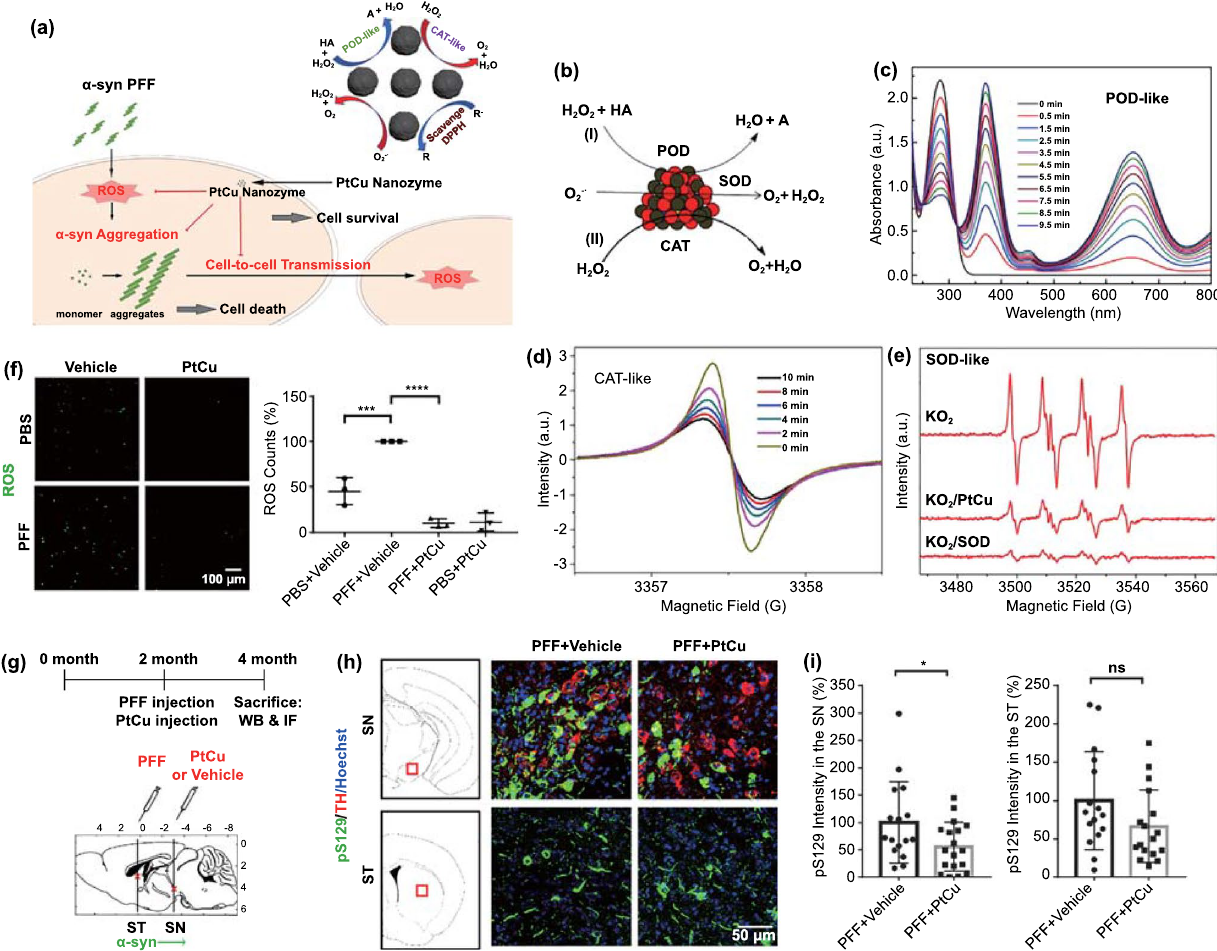
Fig. 10 Example of nano-bio effects resulting in the clearance of excessive ROS. a Schematic showing how the PtCu nanozyme scavenges ROS and prevents α-synuclein-induced pathology, neurotoxicity, and cell-to-cell transmission in vitro and in vivo. b Schematic showing how PtCu Nas mimic three redox enzymes (POD: peroxidase, SOD: superoxide dismutase, CAT: catalase). c UV–Vis spectra of TMB in the presence of H 2 O 2 catalyzed by POD-like PtCu Nas. d CAT-like activity of PtCu NPs in reducing H 2 O 2 , demonstrated by electron spin resonance (ESR) oxi- metry; the evolution of the ESR spectra of PDT over time in the presence of 2 Mm H 2 O 2 before and after the addition of PtCu NPs in a closed chamber can be observed. e The SOD-like activity of PtCu Nas in reducing superoxide levels, demonstrated using ESR spectroscopy. f PtCu Nas reduce PFF-induced ROS and quantifies ROS levels. g Timeline of PFF animal experiments with PtCu Nas treatment (top) and the stereotaxic injection sites for PFF and PtCu/Vehicle (bottom). Two-month-old mice were stereotaxically injected with PFF and PtCu/Vehicle and were sacri- ficed after two months. h Ps129 immunostaining in the substantia nigra (SN) and striatum (ST). Brain sections were stained with anti-Ps129 and anti-TH (tyrosine hydroxylase) antibodies. i Quantification of Ps129 immunostaining. Adapted with permission from Ref. [187]. Copyright 2020 Elsevier Ltd. All rights